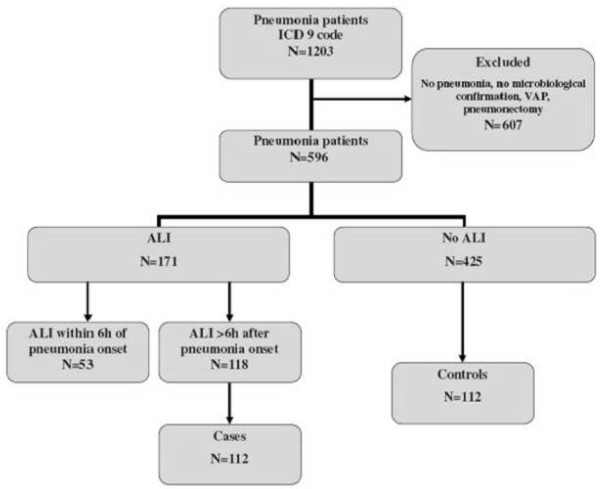
Study flow diagram.